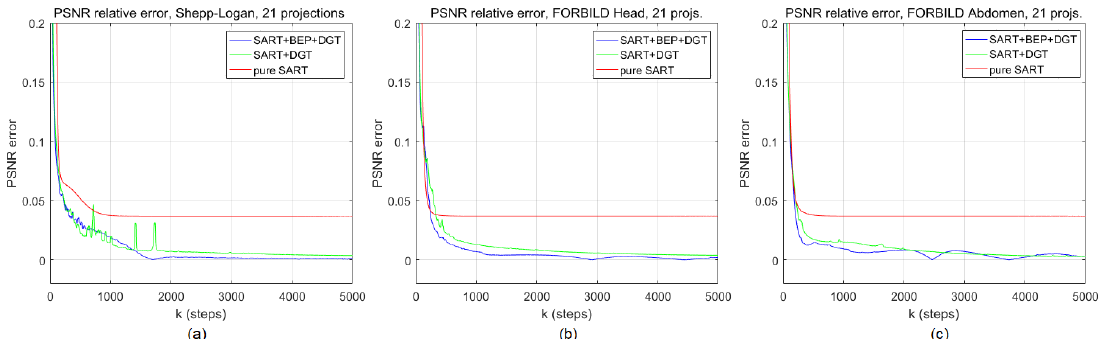
Figure 3. Peak signal-to-noise ratio (PSNR) difference along k iterations, 1 < k ≤ 5000, for the pure simultaneous algebraic reconstruction technique (SART), SART+discrete gradient transform (DGT), and SART+bilateral edge-preserving (BEP)+DGT reconstructions for ( a ) Shepp–Logan head phantom, ( b ) FORBILD head phantom, and ( c ) FORBILD abdomen